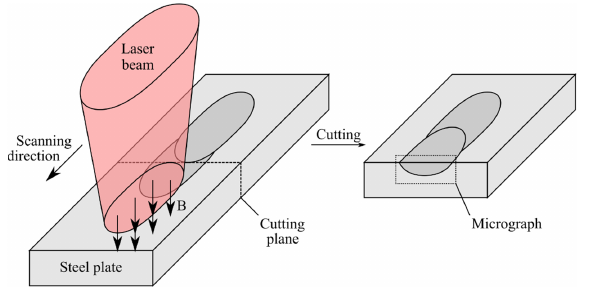
Figure 1. Scheme of the experimental setup.